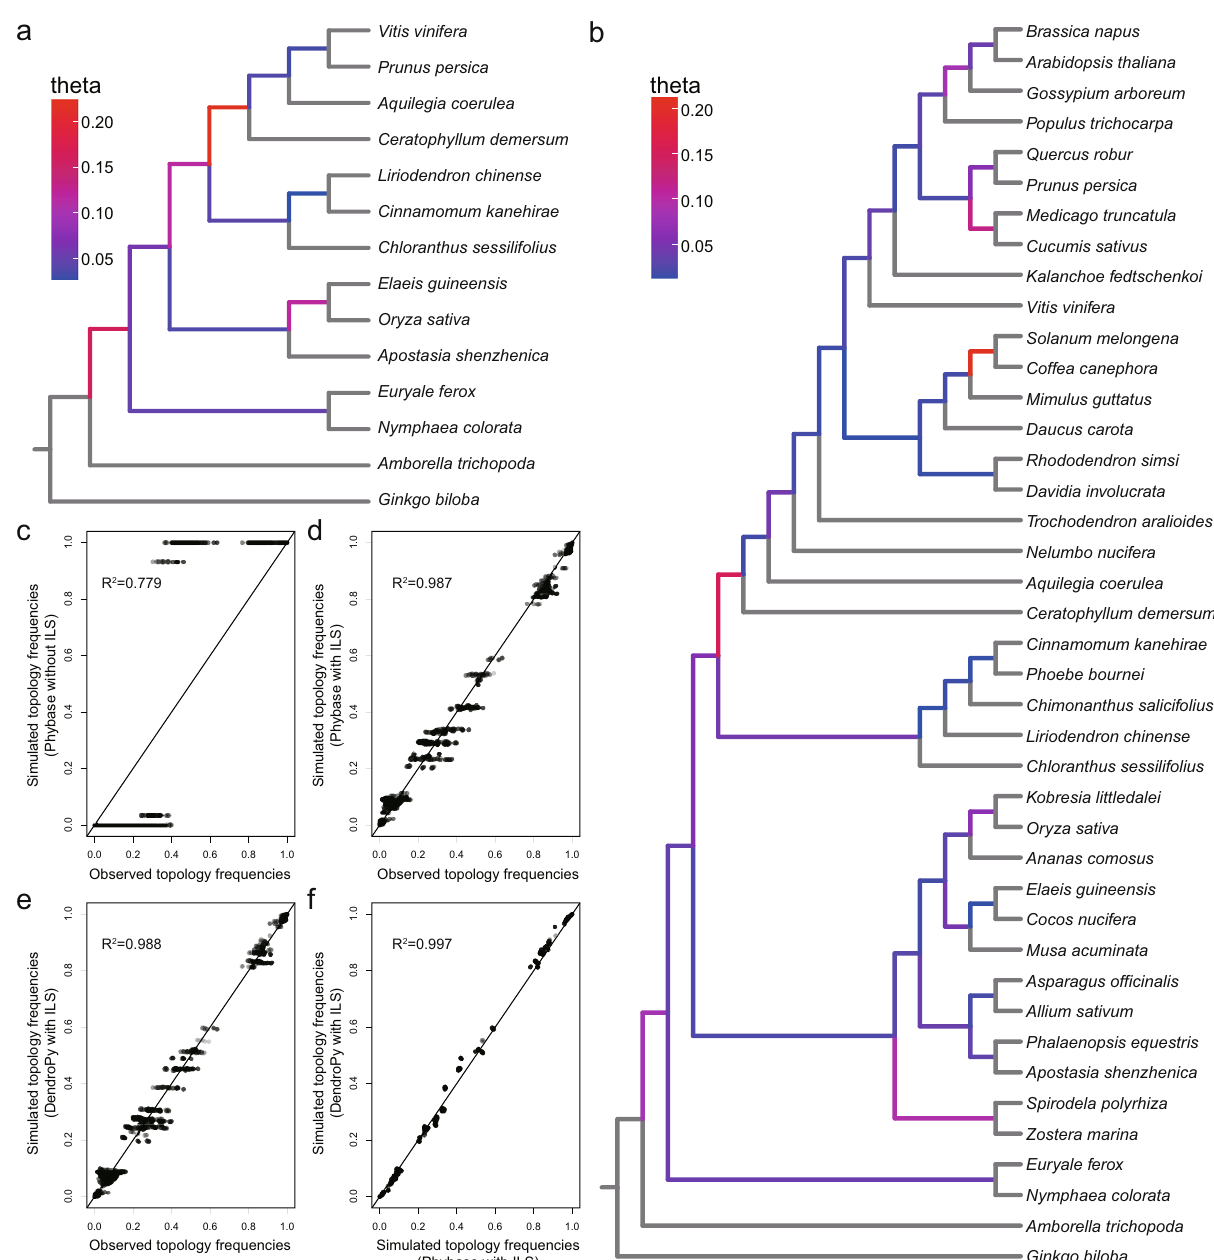
Fig. 4 ILS analyses. a Estimated theta value for each internal branch of the 14 species. b Estimated theta value for each internal branch of the 41 species. Warmer colors indicate higher theta and thus higher ILS level. Terminal branches are colored gray due to lack of data to infer theta. c – f represent the correlation analyses of topology frequency of each quartet species combination in the different dataset: the simulation without ILS by Phybase and empirical observation ( c ), the simulation with ILS by Phybase and empirical observation ( d ), the simulation with ILS by DendroPy and empirical observation ( e ), the simulation with ILS by Phybase and DendroPy ( f ). The “ lm() ” function in R was used to perform all the correlation analyses, and the p values were both less than 0.01. Source data are provided as a Source Data fi